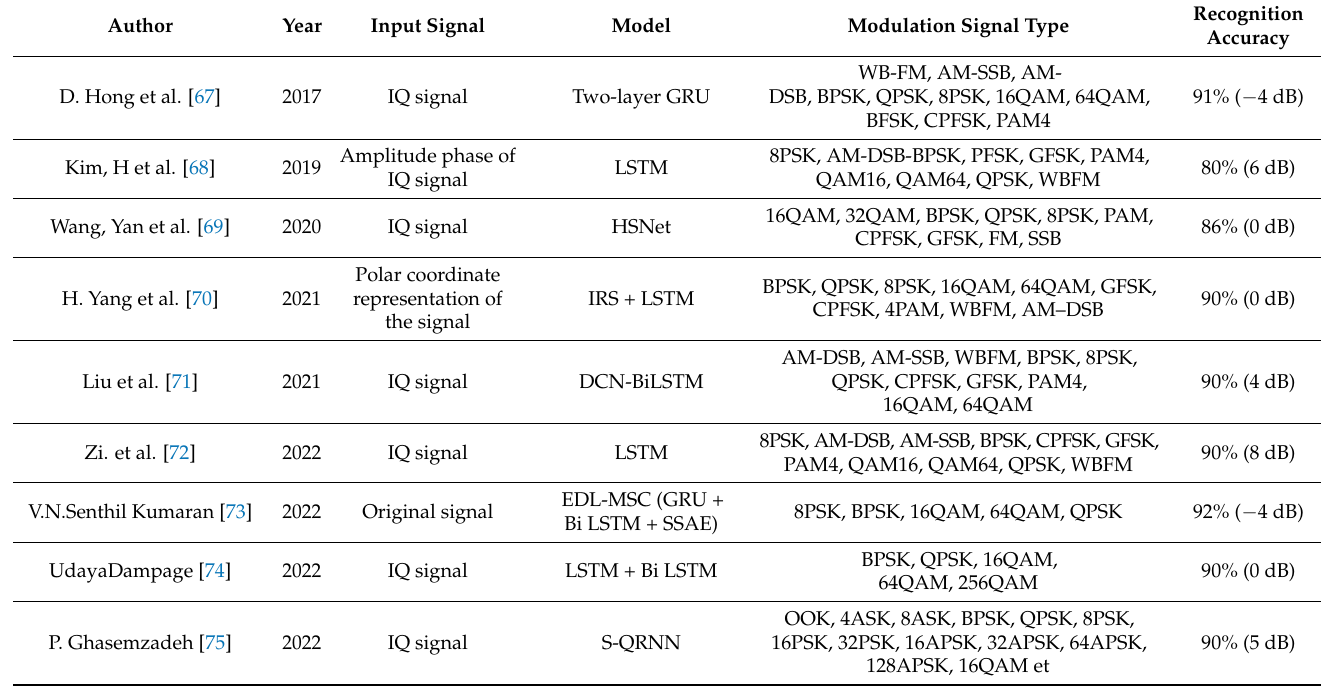
Table 2. Summary of modulation recognition algorithms based on cyclical neural